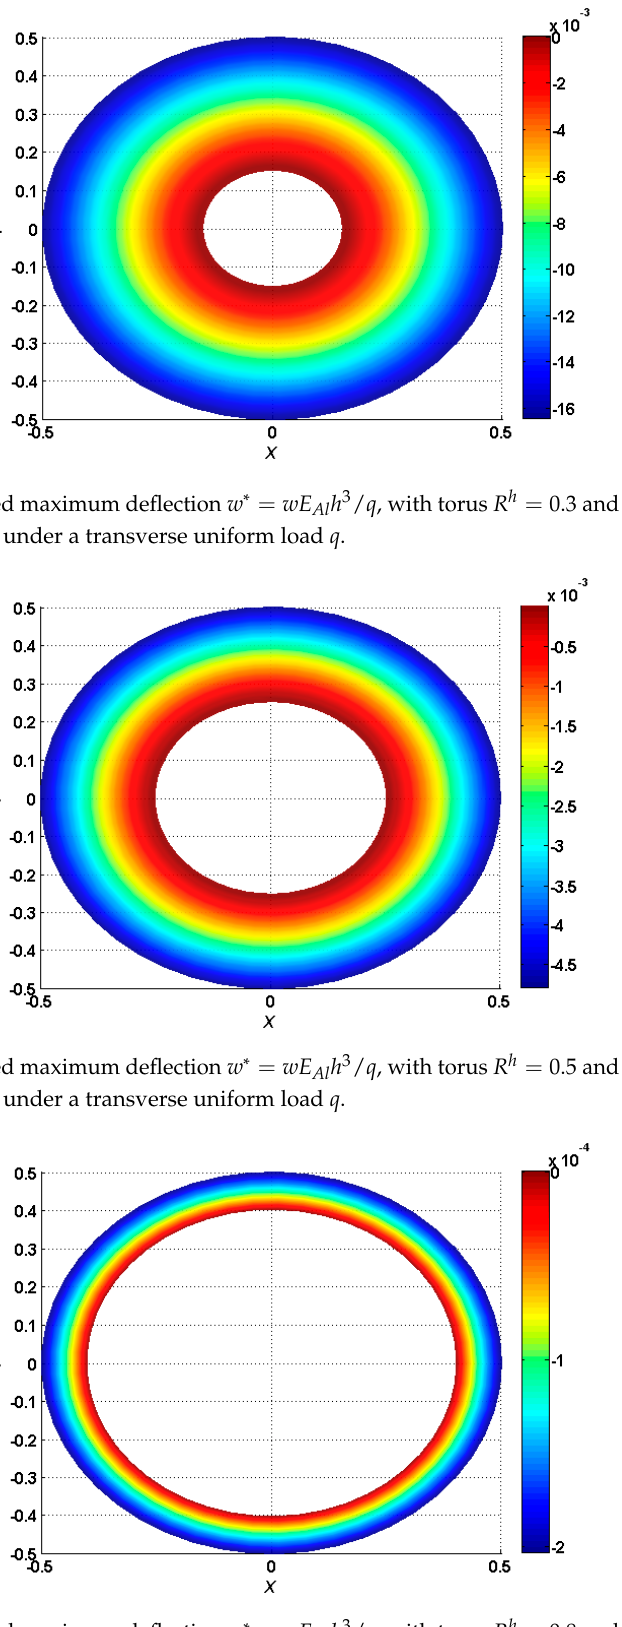
Figure 16. Normalized maximum deflection w ∗ = wE Al h 3 / q , with torus R h = 0.8 and internal clamped boundary conditions under a transverse uniform load q .